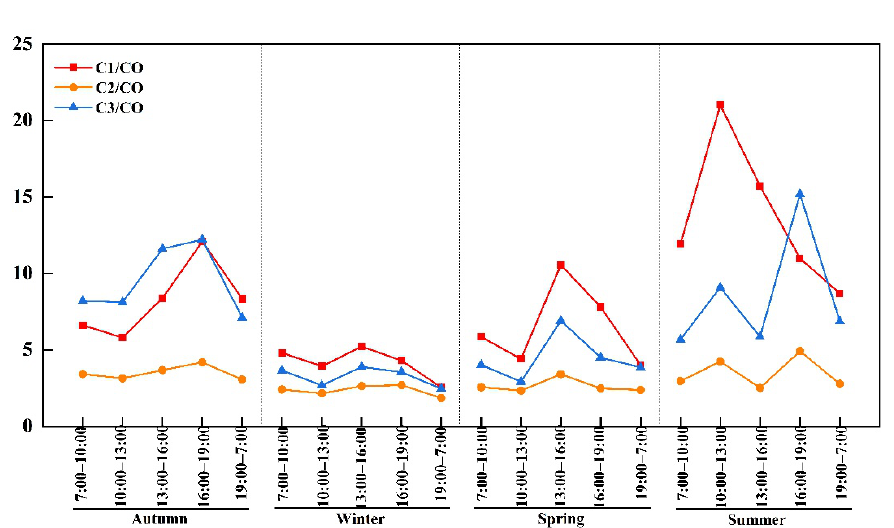
Atmosphere 2021 , 12 , 510 Figure A1. The concentration ratios of formaldehyde/CO (C 1 /CO), acetaldehyde/CO (C 2 /CO) and acetone/CO (C 3 /CO).